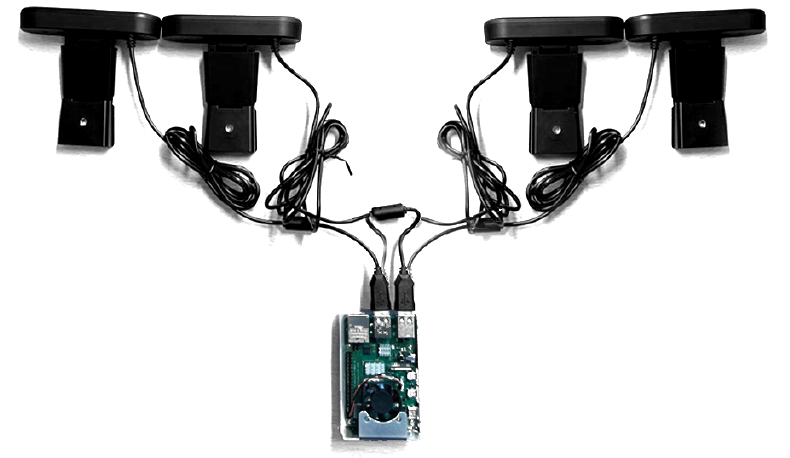
Figure 2. Hardware configuration.